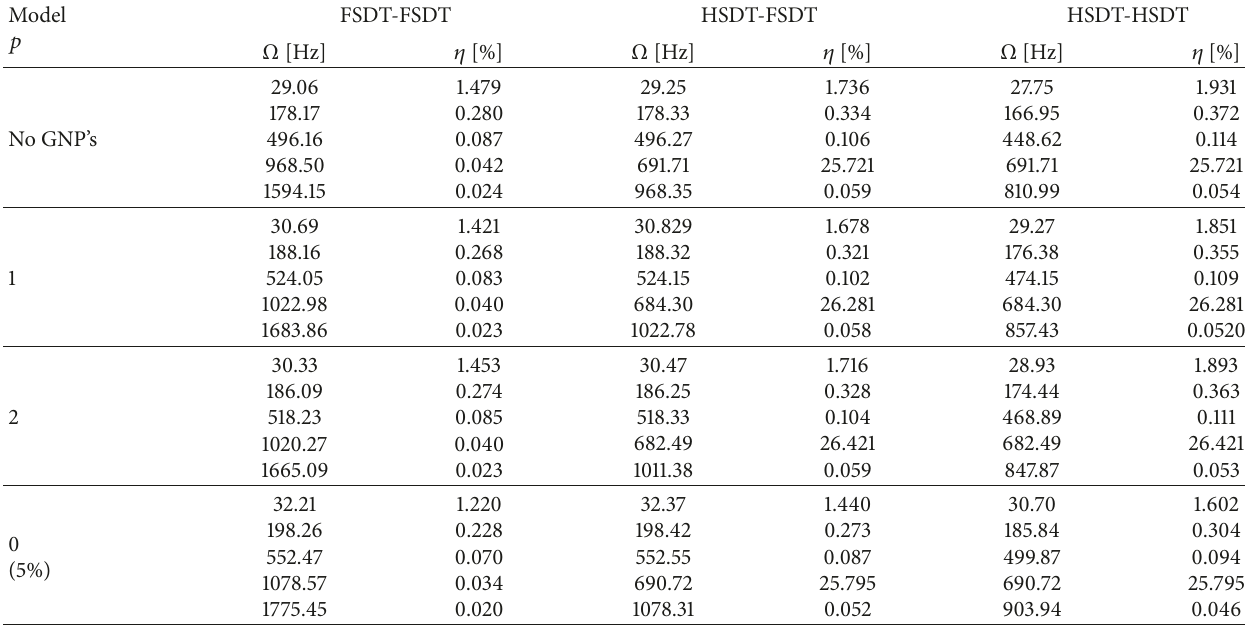
Table 14: Frequencies Ω and loss factors 𝜂 . 𝑤 max GNP = 5